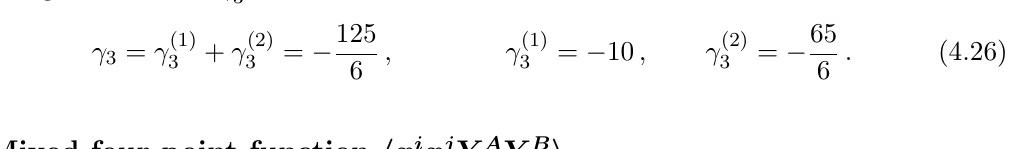
Figure 4 . Loop diagrams contributing to 1 stands for the bosonic and fermionic one-loop diagrams in (cid:12)gure 3. In (b) it stands for the two-loop irreducible contributions like or reducible iterations of one-loop diagrams as in